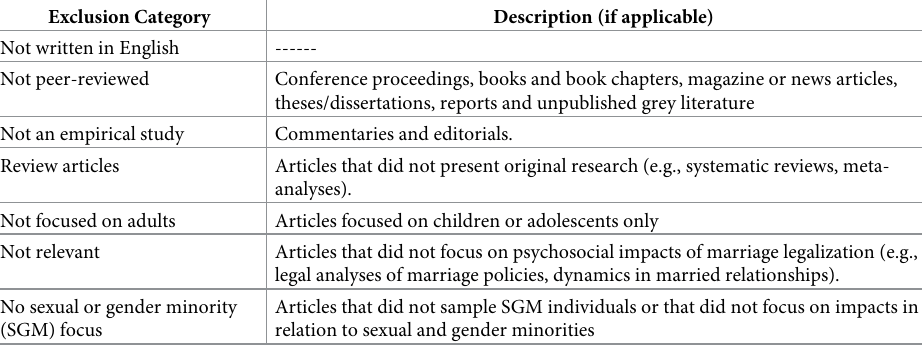
Table 1. Exclusion categories used for title and abstract review.